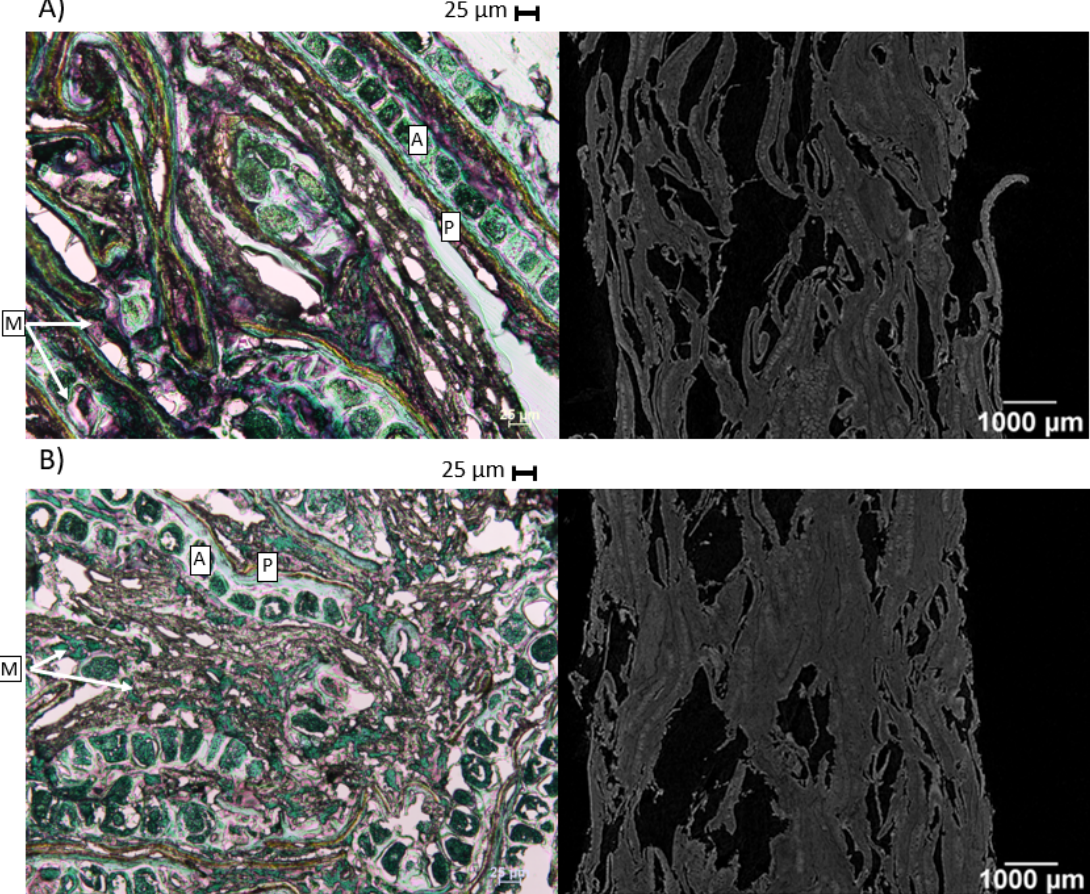
Figure 3. Light microscopy pictures ( left ), where starch is stained with Lugol solution (purple) and proteins are stained with light green (green) and X-ray tomography pictures ( right ) of ( A ) low shear extruded wheat bran at 23% of total moisture using the low-temperature profile and ( B ) very high shear extruded wheat bran at 23% of total moisture using the low-temperature profile. P = pericarp; A = aleurone; M = matrix surrounding the bran particles.